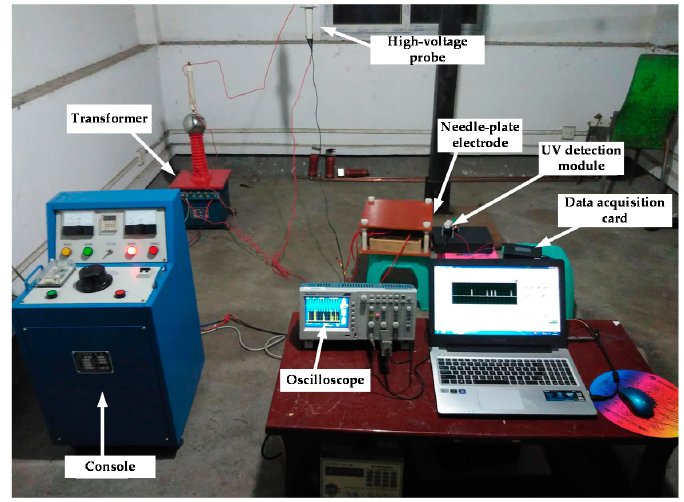
Figure 10. Experimental platform.